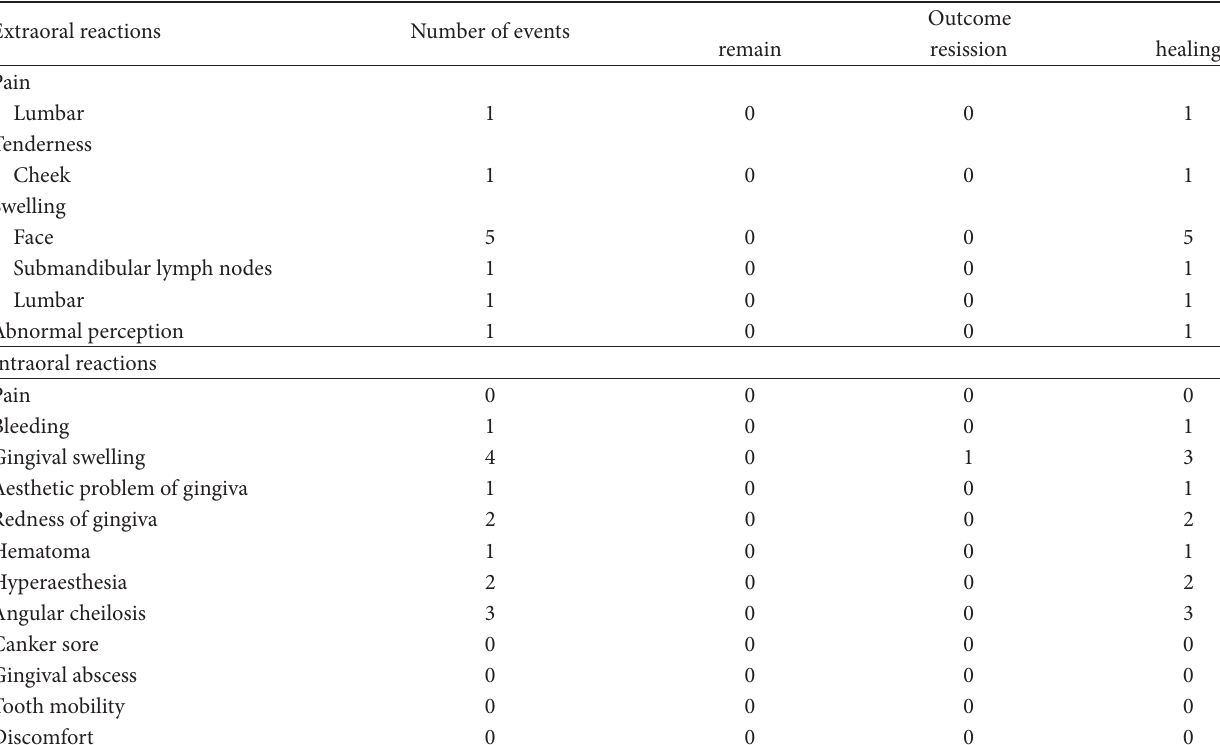
Table 2: Adverse event.